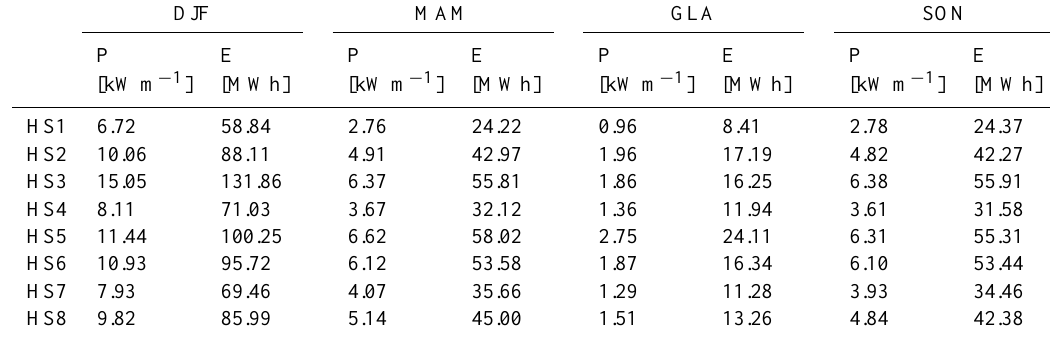
Table 5. Seasonal distribution of the average wave energy flux per unit crest length for the selected sites. DJF MAM GLA